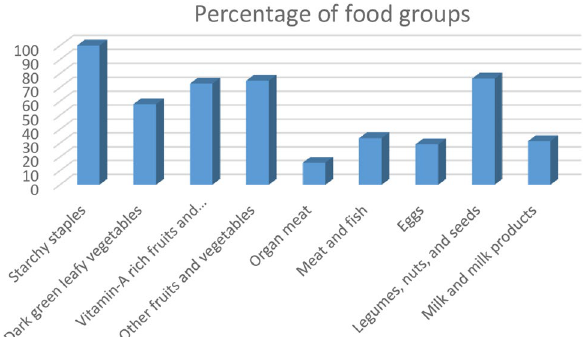
Figure 1. The prevalence of IDD food groups consumed by PLHIV in all ART clinics of Bahir Dar, 2017 (N = 413).